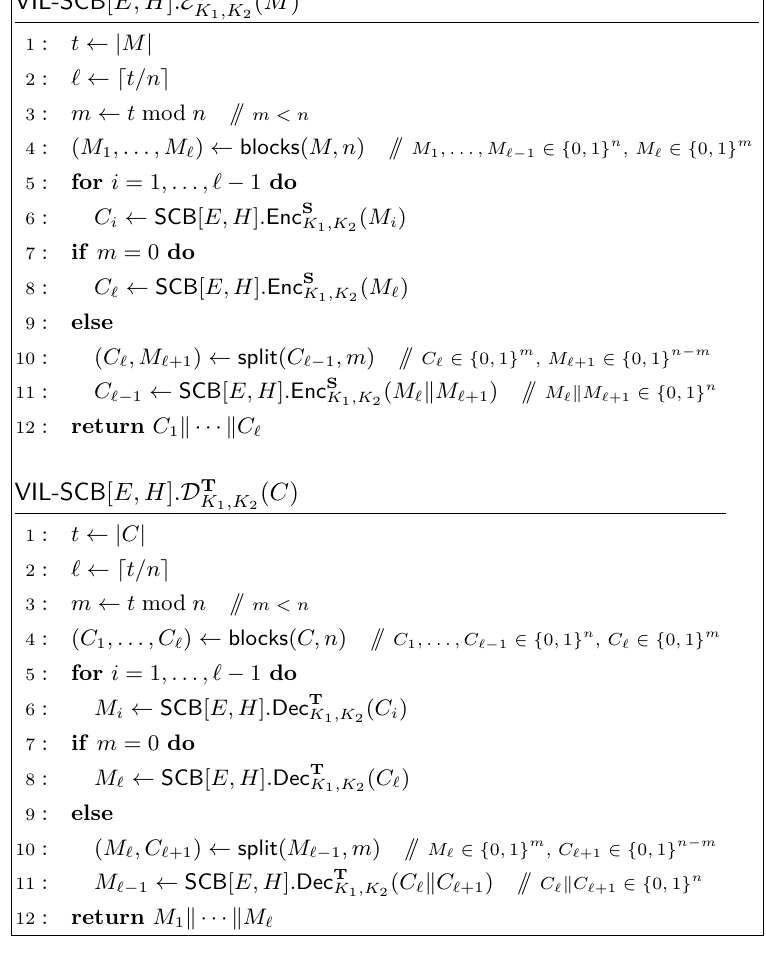
Figure 11: Encryption and decryption algorithms of VIL-SCB [ E, H